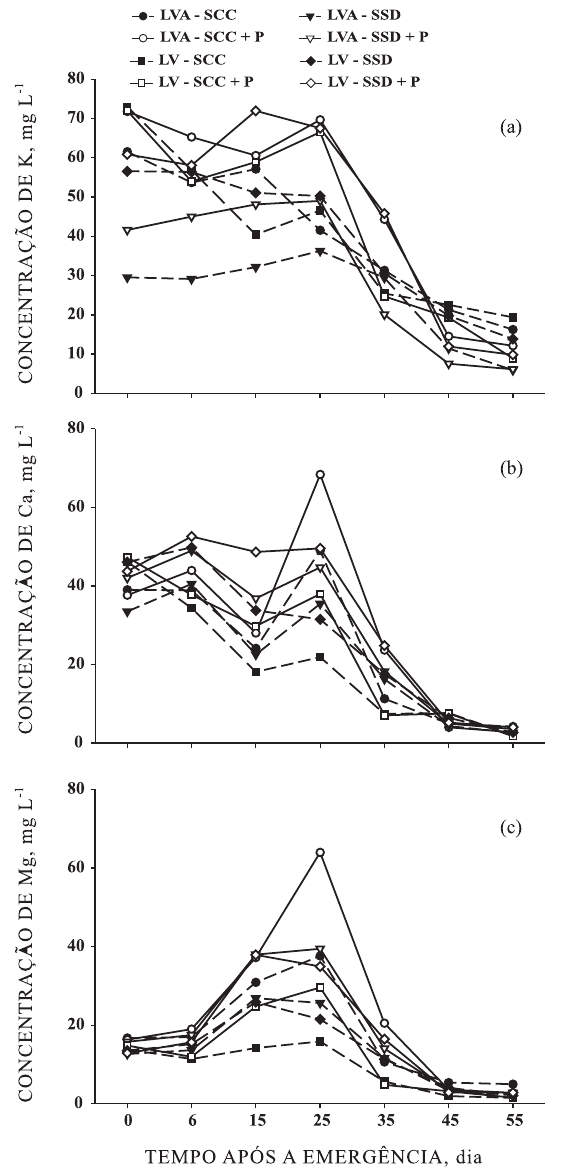
Figura 1. Concentrações de potássio (a), cálcio (b) e magnésio (c) na solução de dois Latossolos durante o ciclo de crescimento da soja, em função do manejo e da fertilização